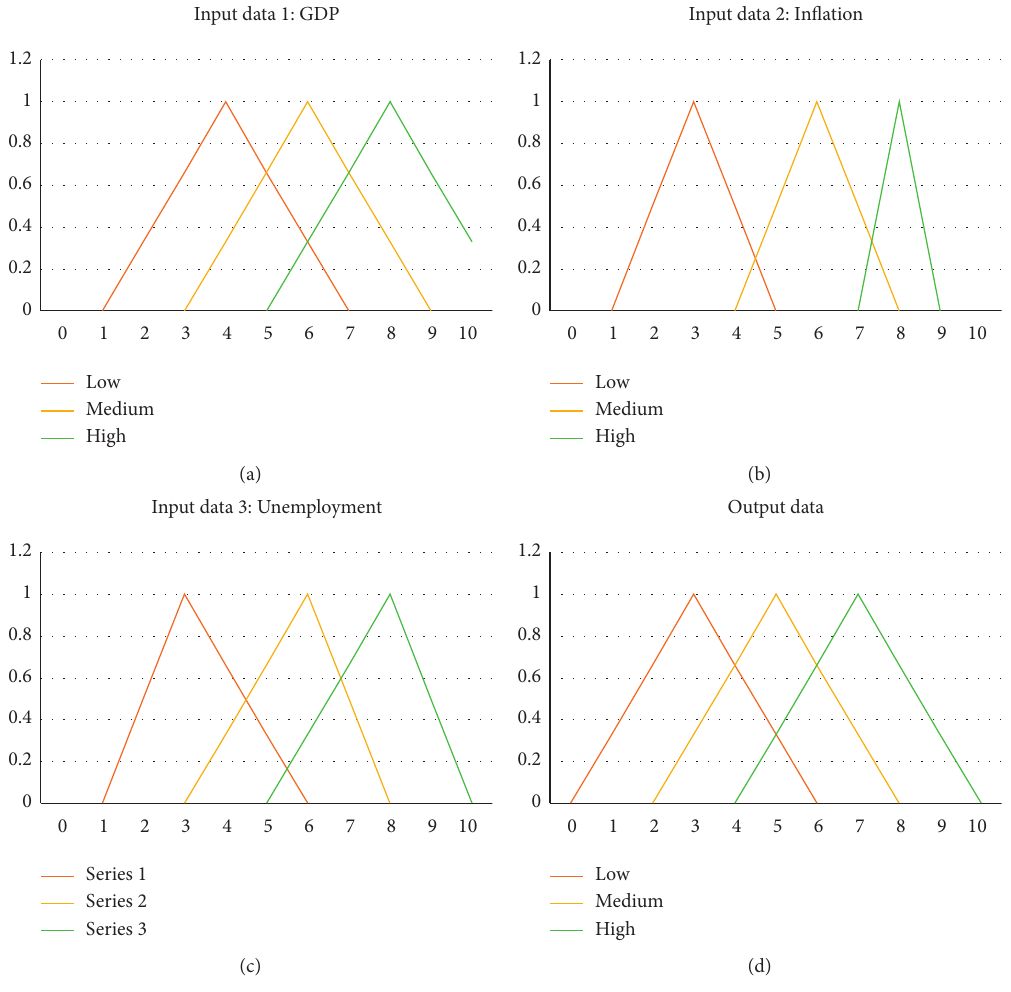
Figure 2: Triangular membership functions related to the inputs and outputs of fuzzy